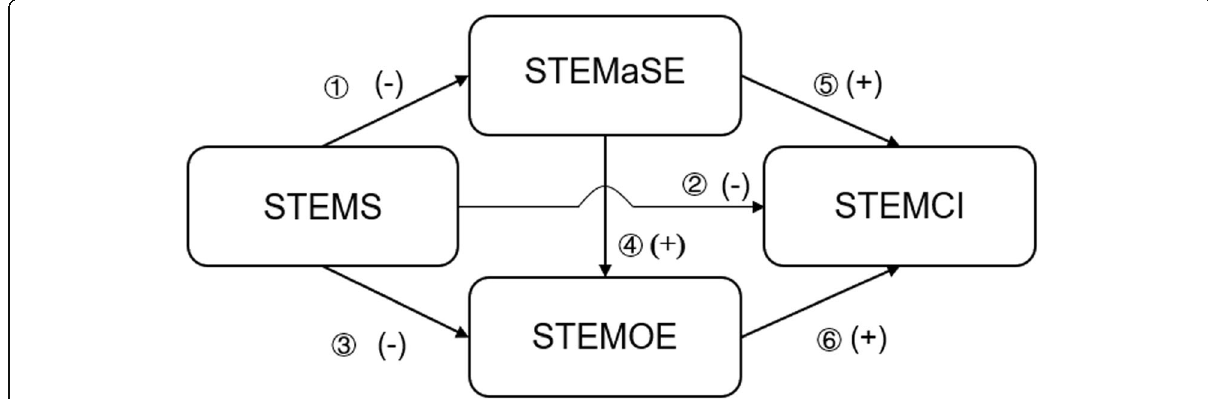
Fig. 2 Hypothesized model A (STEMS refers to STEM stereotypes, STEMaSE refers to self-efficacy in STEM activities, STEMOE refers to STEM outcome expectations, and STEMCI refers to STEM career interest. The paths are numbered. For example, path ① indicates the path from STEM stereotypes to self-efficacy in STEM